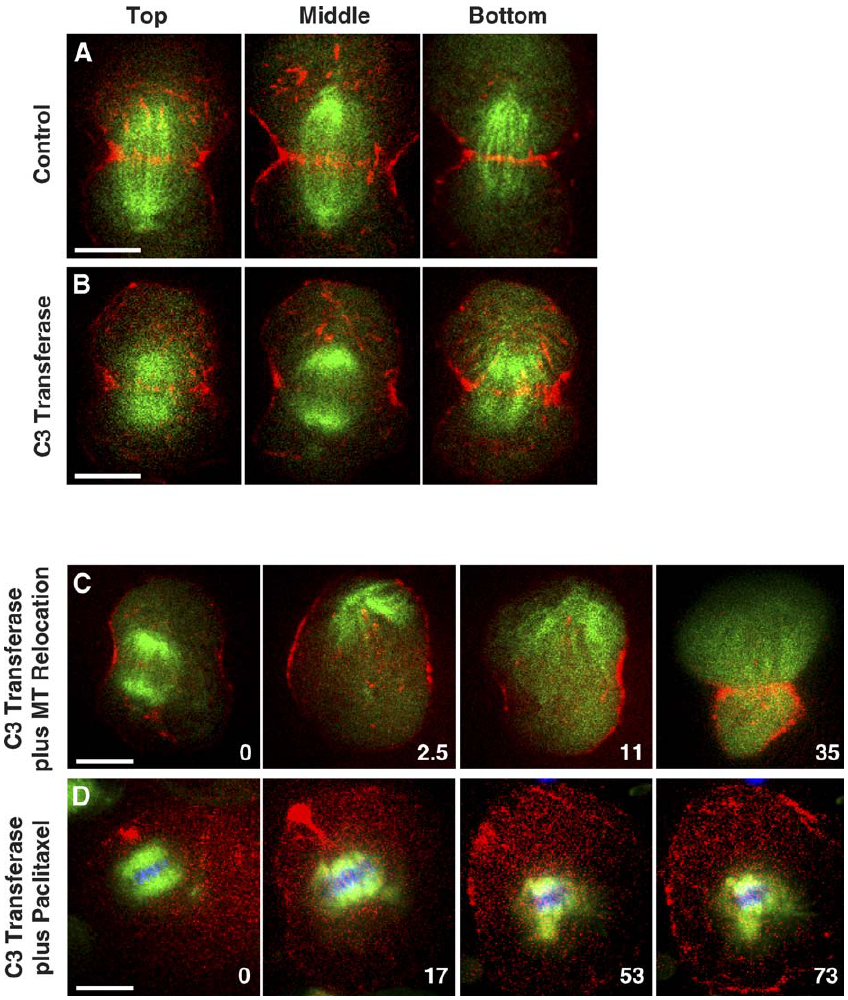
Figure 7. Equatorial Stimulation, but Not Redistribution of Cortical Actin, Was Dependent on RhoA Activity (A) A cytokinetic control cell, optically sectioned lengthwise, displayed actin aggregates at the microtubule plus ends of its spindle, both at the equatorial cortex (top and bottom) and in the central spindle (middle). Cells in (A and B) were labeled as in Figure 1B. (B) In a cytokinetic cell microinjected with C3 transferase to inhibit RhoA, actin aggregates at the microtubule plus ends of the central spindle were absent. (C) Despite inhibition of RhoA, actin flow was induced (2.5–11), following manipulation of the collapsed spindle to one side of the cell (2.5). Excluded filaments assembled into a contractile ring (35). Cell was labeled as in Figure 1B, and microinjected with C3 transferase. (D) In a cell treated with paclitaxel and C3 transferase, the furrow failed to initiate due to inhibition of both pathways for redistribution of actin. Actin filaments were scattered in the cytoplasm long after the cell entered anaphase, as determined by the presence of splaying microtubules (17–73). (D) was labeled as in Figure 5C. Time in min. Time 0 in (C), late anaphase; in (D), metaphase-anaphase transition. Bars, 10 l m.